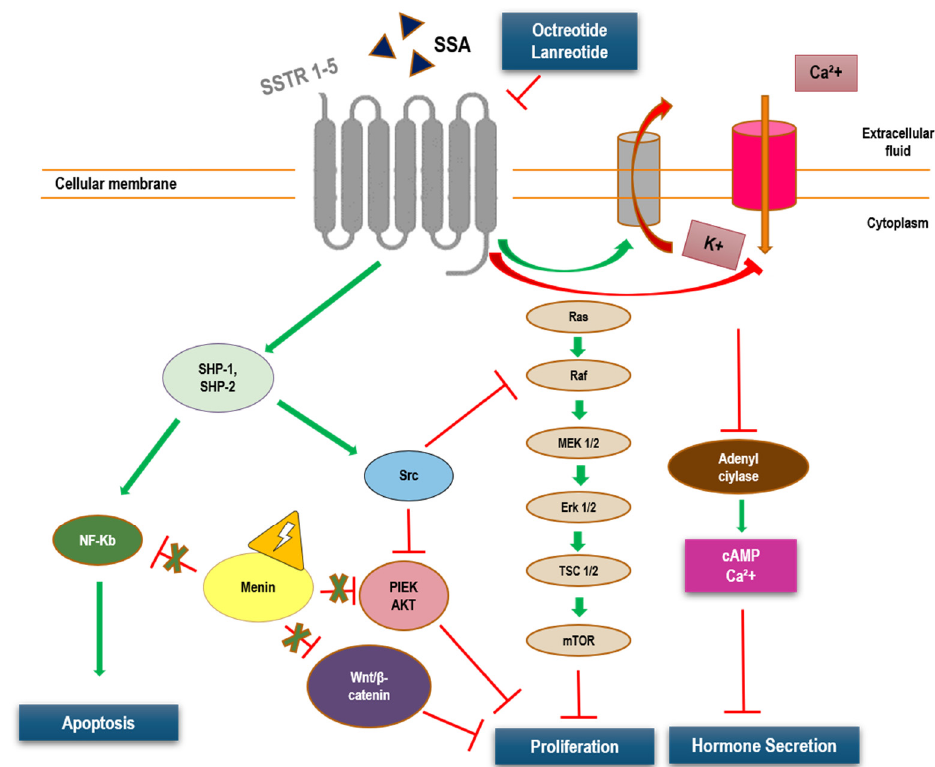
Figure 3. Mechanism of action of SSA in patients with MEN-1. Abbreviations: AKT, protein kinase B; cAMP, cyclic adenosine monophosphate; Erk, extracellular signal-regulated kinase; Ca 2+ , calcium; K+, potassium; MEK, mitogen-activated extracellular signal-regulated kinase; mTOR, mammalian target of rapamycin; PI3K, phosphoinositide 3-kinase; Src, proto-oncogene tyrosine protein kinase Src; SSA, somatostatin analogue; SSTR, somatostatin receptors; TSC, tuberous sclerosis complex.